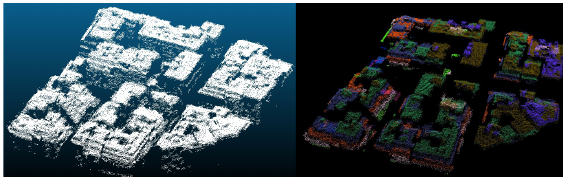
Figure 5. The input point cloud (left) and the segmented per 3m cleaned point cloud of the urban area (right)